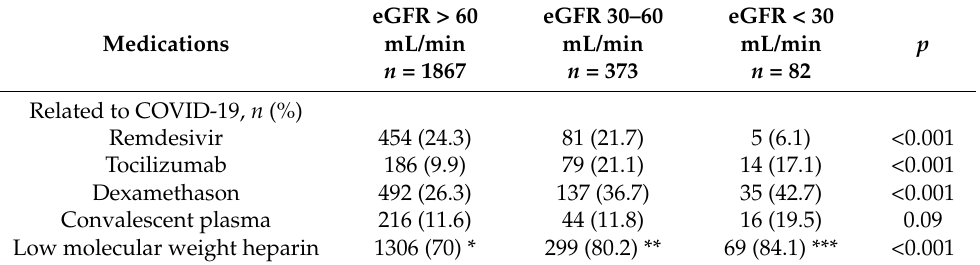
Table 3. In-hospital treatment for COVID-19 according to the baseline kidney function.